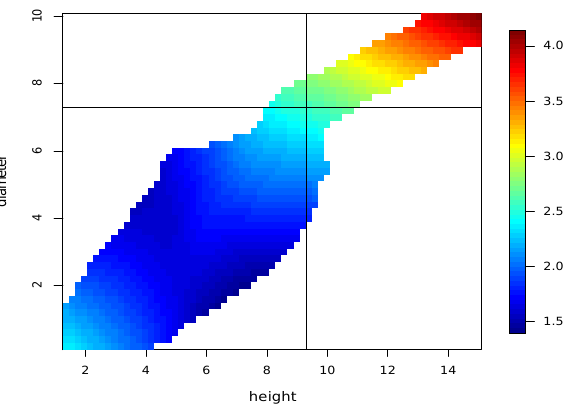
Figure 6. Fitted and predicted interaction function for the the restricted S-ANOVA model. The vertical line indicates the height value from which we predict (9.32) and the horizontal line indicates the diameter value from which we predict